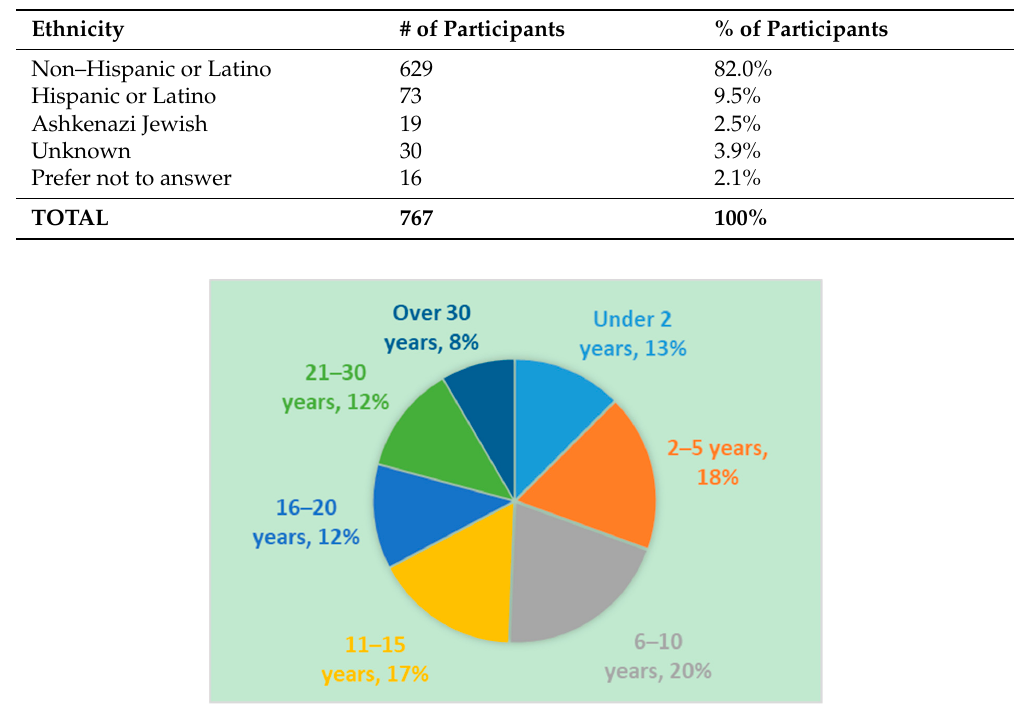
Figure 1. Age of Registry participants at time of enrollment. Registry participants range in age from newborn infants to adults. The majority of registry participants are under 15 years of age.